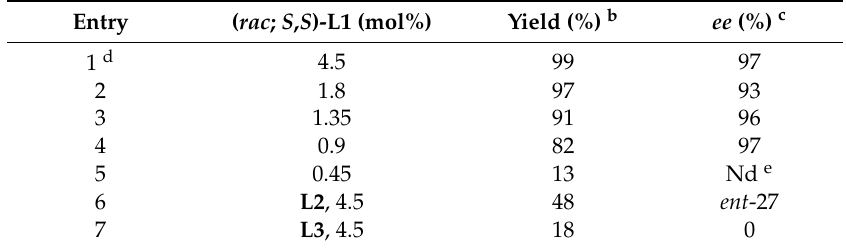
Table 3. Effect of the amount of chiral ligand and ligand structure on the conjugate addition reaction of 3 a . Entry